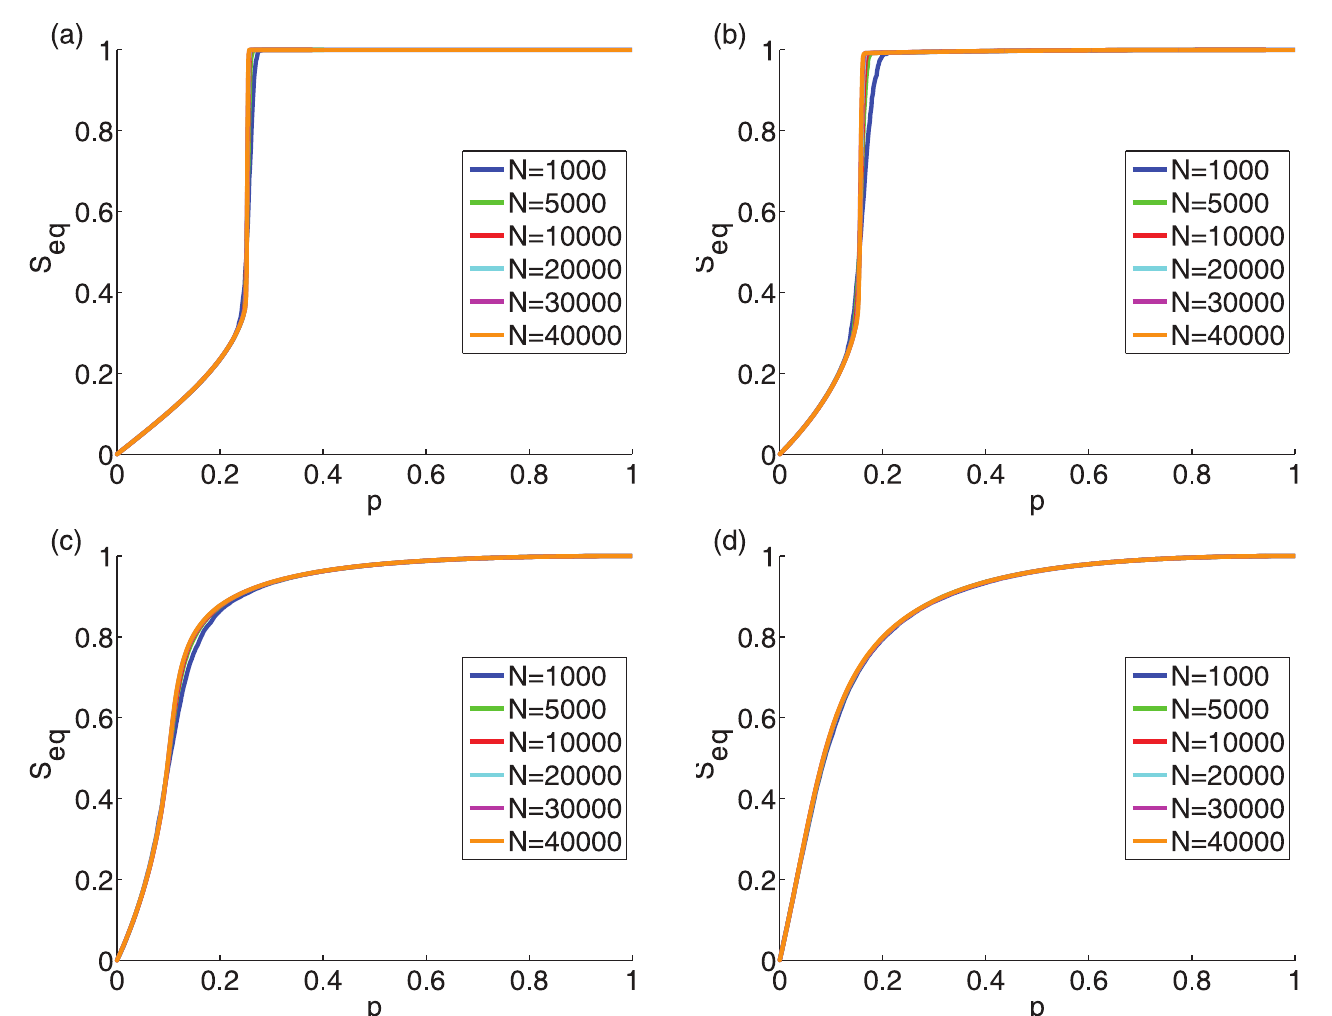
Fig 4. Finite-size behavior of the final cascade size S eq vs. the initiator fraction p for ER graphs with average degree z = 10. The mean threshold is ϕ 0 = 0.50 while the standard deviation of the threshold is (a) σ = 0.00, (b) σ = 0.20, (c) σ = 0.26 and (d) σ = 0.28.